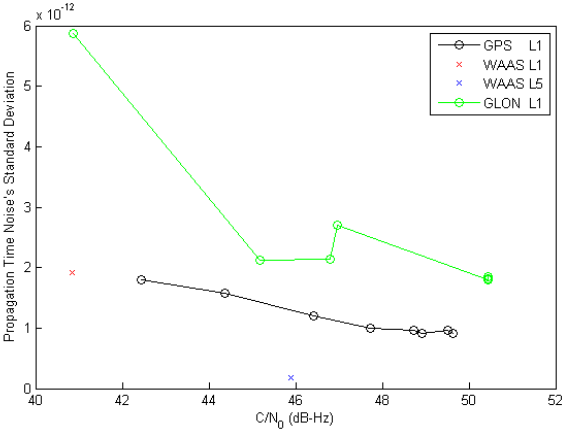
Figure 12. Different Correlator Spacing (Through Different Signals) Impact on DLL Noise vs. (cid:1829) (cid:1840) (cid:2868) ⁄ .